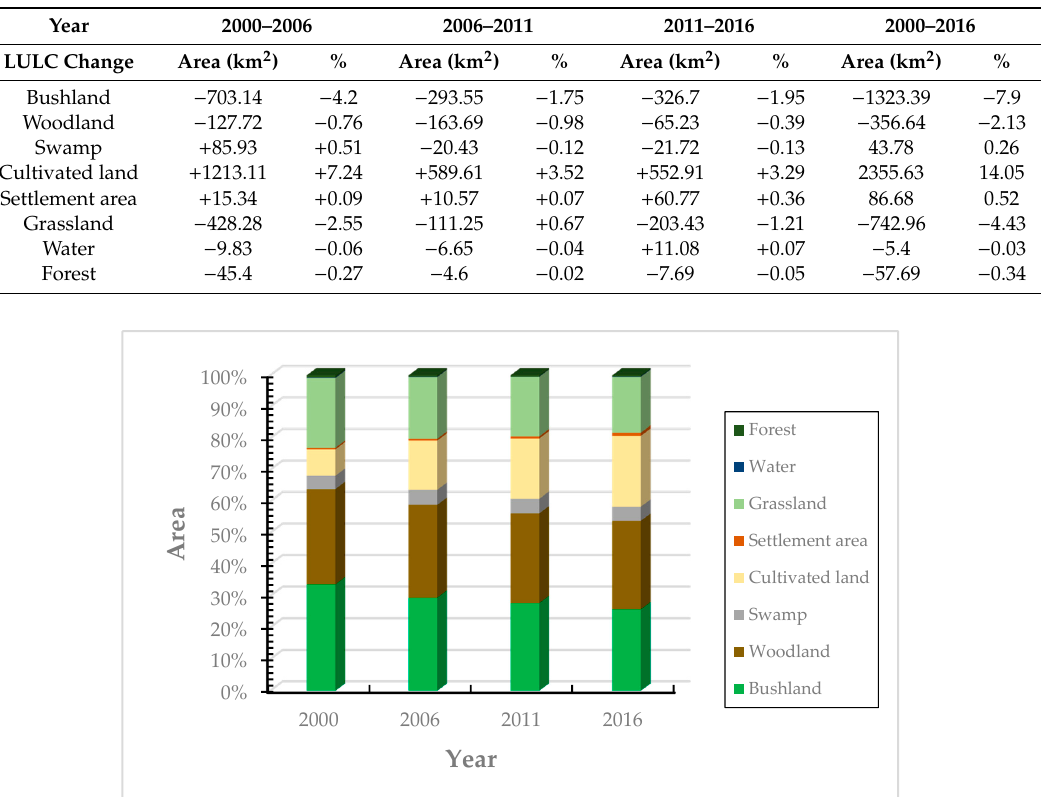
Figure 2. LULC change graph for 2000, 2006, 2011, and 2016 at Kinyasungwe Sub-catchment. Table 6. Results of the LULC classification for 2000, 2006, 2011, and 2016 images showing the area changed and percentage at Kinyasungwe Sub-catchment.